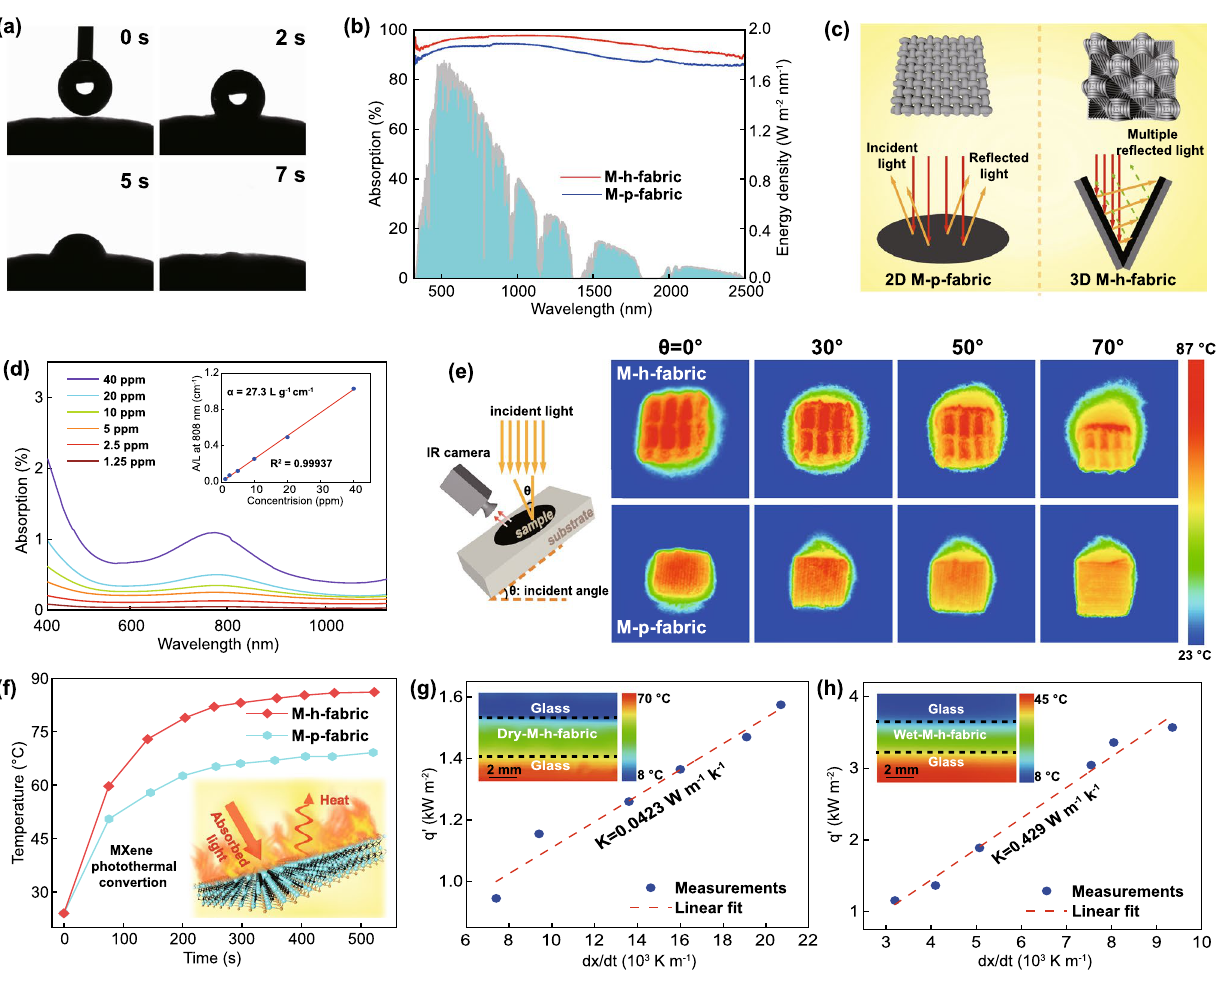
Fig. 3 a Hydrophilicity of the MXene/3D honeycomb fabric. b Absorption spectra of the M-h-fabric and M-p-fabric (sample names: M = MXene, h = honeycomb, p = plain). c Schematic diagram of the reflection process of sunlight on different fabrics. The 2D plain fabric reflects sunlight only once, whereas the 3D honeycomb fabric reflects sunlight multiple times. d Absorption spectra of MXene solutions with different weight concentrations. Inset: Lambert–Beer law absorbance plot for absorption at 808 nm. e IR images of the M-h-fabric and M-p-fab- ric at incidence angles of 0, 30, 50, and 70°. Inset: Schematic of the incidence angles. f The variations of surface temperature for the M-h-fabric and M-p-fabric under the irradiation of 1 solar intensity. Inset: Schematic of the photothermal conversion of MXene. g – h Thermal conductivity of dry and wet M-h-fabrics. Insets: Representative images taken by the IR